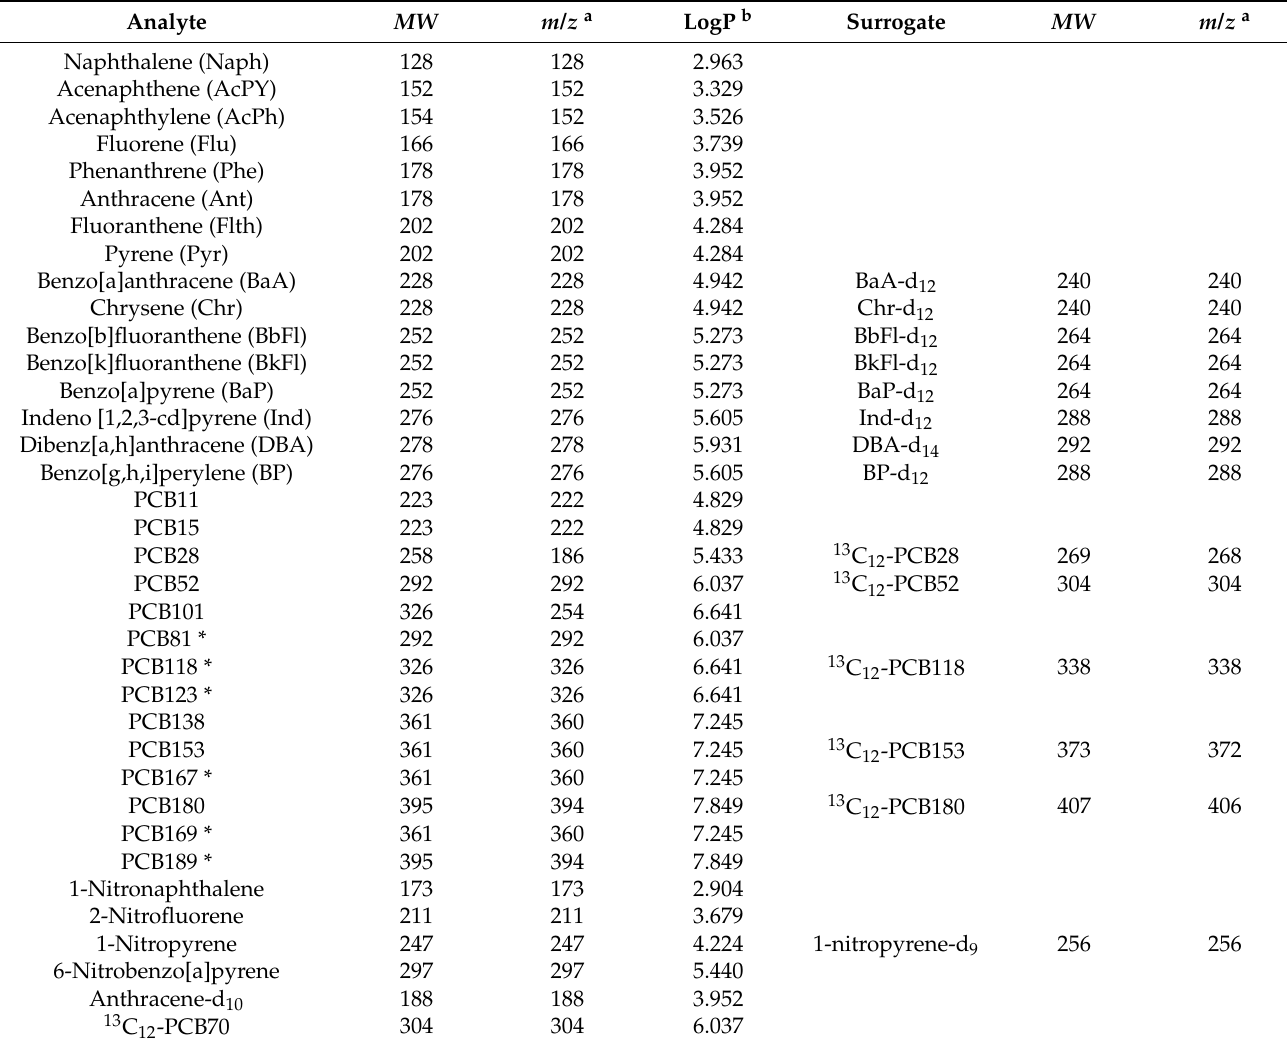
Table 1. List of internal standards, target analytes and their labelled isotopes (surrogates), together with their relative molecular weight ( MW ), tyipical mass/charge values ( m / z ) and octanol/water partition coefficient (logP). PCB dioxin-like are marked